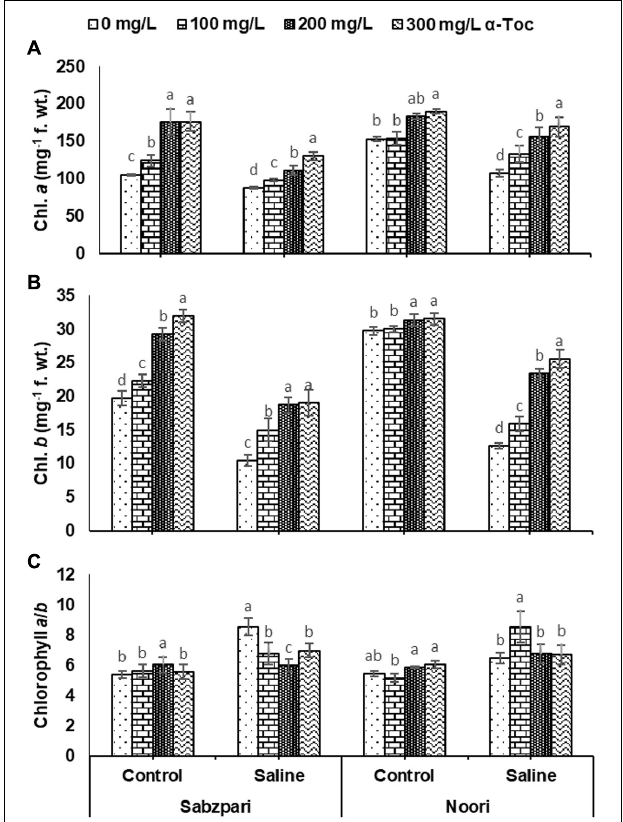
FIGURE 4 | Total Chl. (A) , Total Car. (B) , β - Carotene (C) of okra varieties sprayed with different levels of α -tocopherol under saline conditions. Values represent means ± S.D. Significant differences among row spacing were measured by the least significant difference (LSD) at p > 0.05 and indicated by different